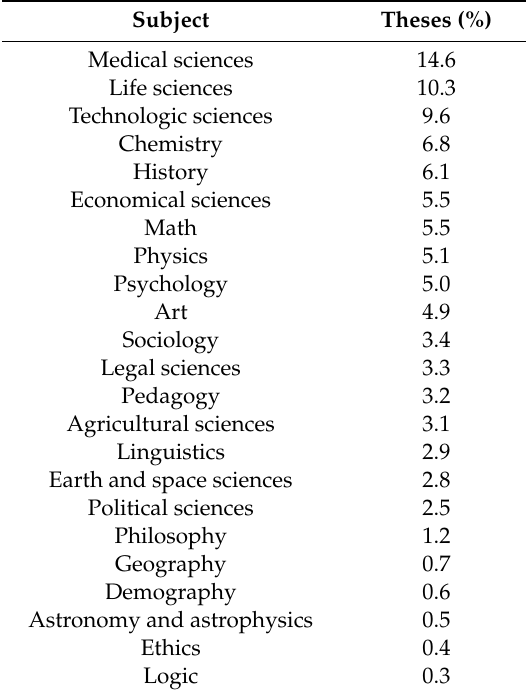
Table 2. Doctoral theses per subject.